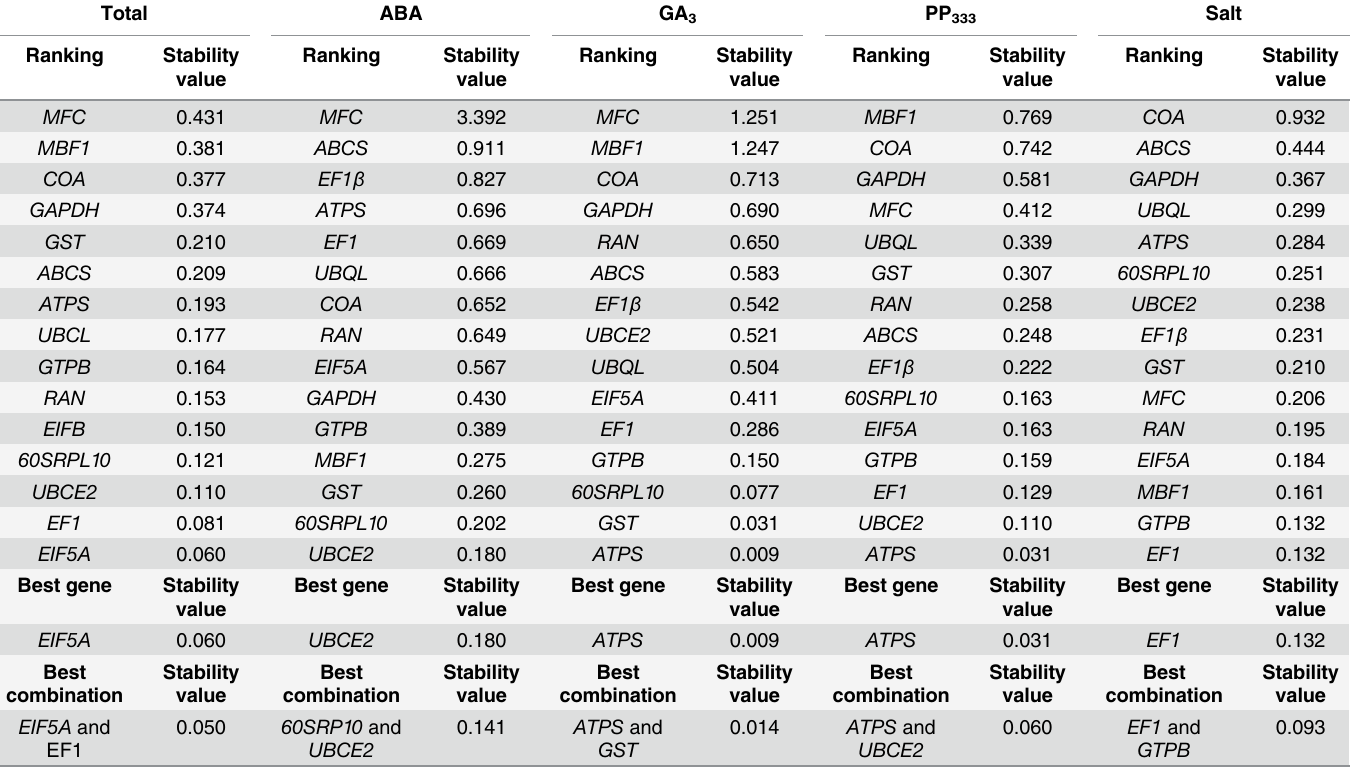
Table 5. Expression stability values of safflower RGs as calculated by NormFinder